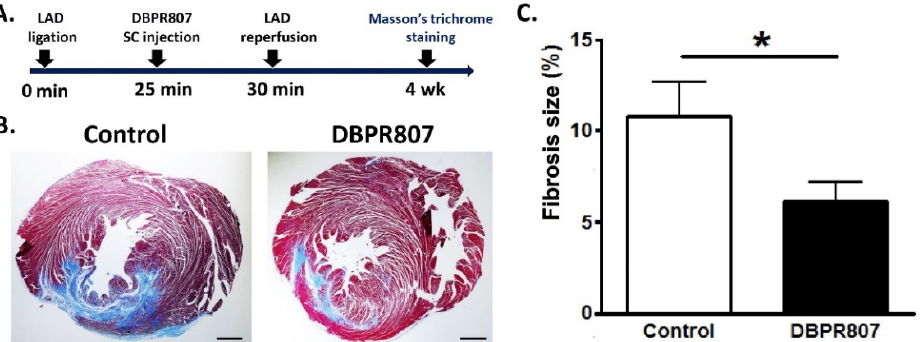
Figure 4. Fibrosis assessment in rats. Rats were treated with or without DBPR807 (5 mg/kg, SC) at 25 min after LAD artery ligation in heart (control, n = 15; DBPR807, n = 16). Fibrosis size was evaluated 4 weeks after IR injury via Masson’s trichrome staining. ( A ) Treatment protocol. ( B ) The fibrosis of tissue was stained in blue; scale bar = 1 mm. ( C ) The fibrosis size of the heart section from the rat was quantified as the ratio of fibrosis (blue) area to the left ventricle (LV) area. The data are presented as mean ± SEM. Statistical analysis was performed by t -test: * p < 0.05.